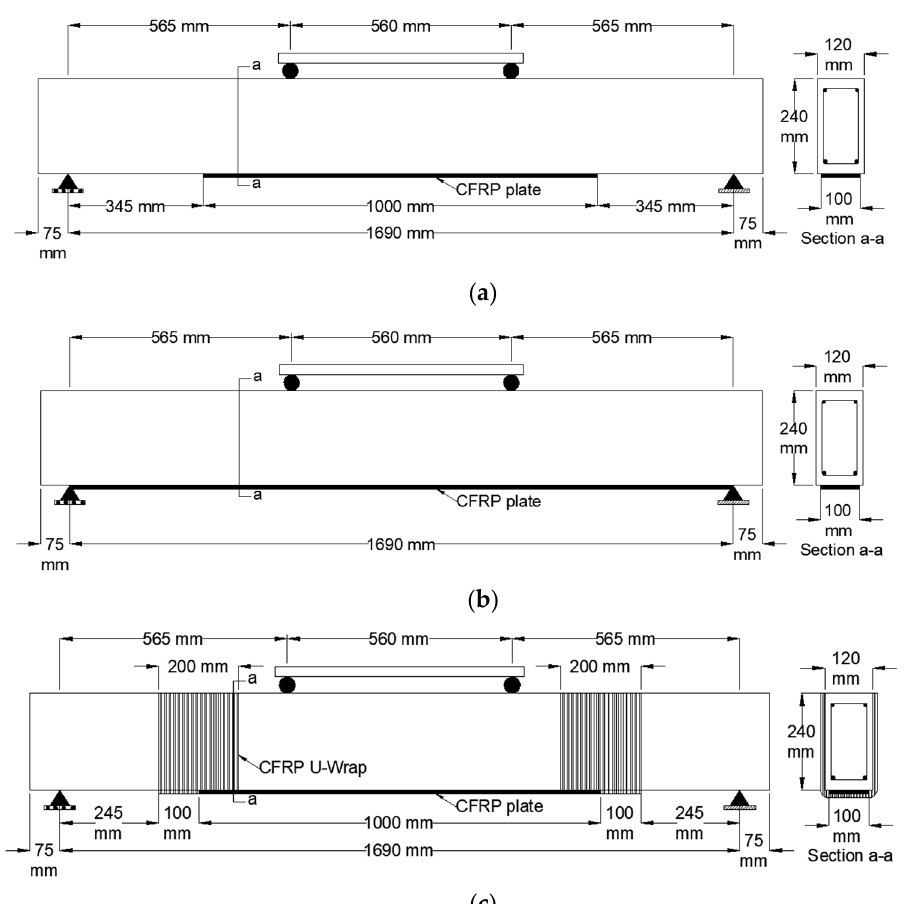
Figure 2. Strengthening details of specimens: ( a ) S; ( b ) F; ( c ) S-U.